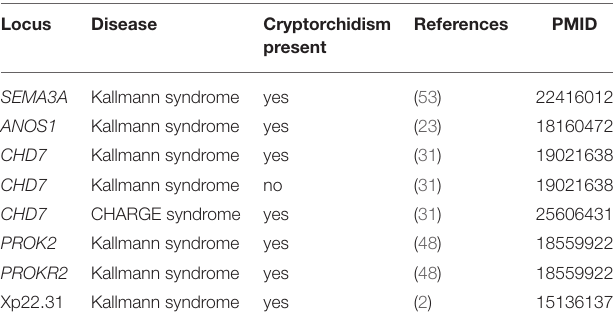
TABLE 3 | Example of heterogeneity of genotype-phenotype relations in association with cryptorchidism. Locus Disease Cryptorchidism